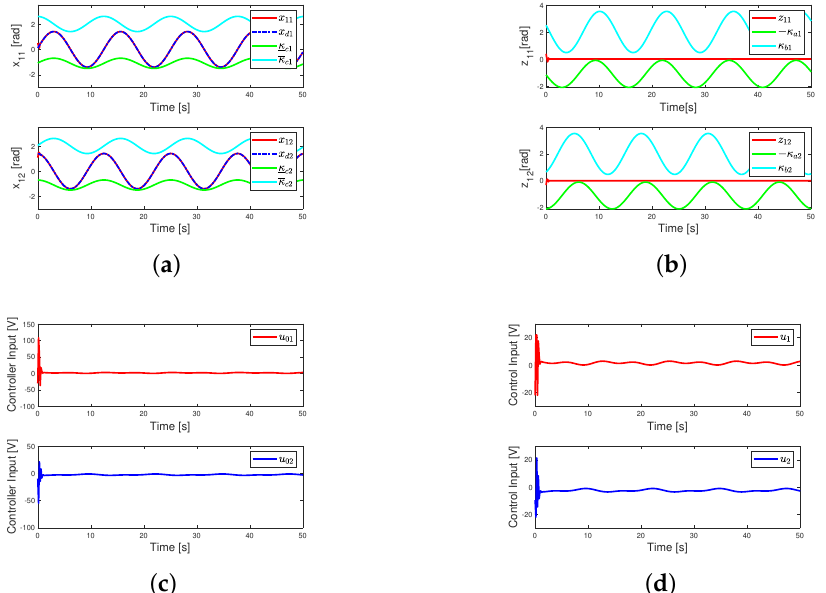
Figure 2. The control performance. ( a ) tracking performance of x 1 ; ( b ) tracking error: z 1 ; ( c )